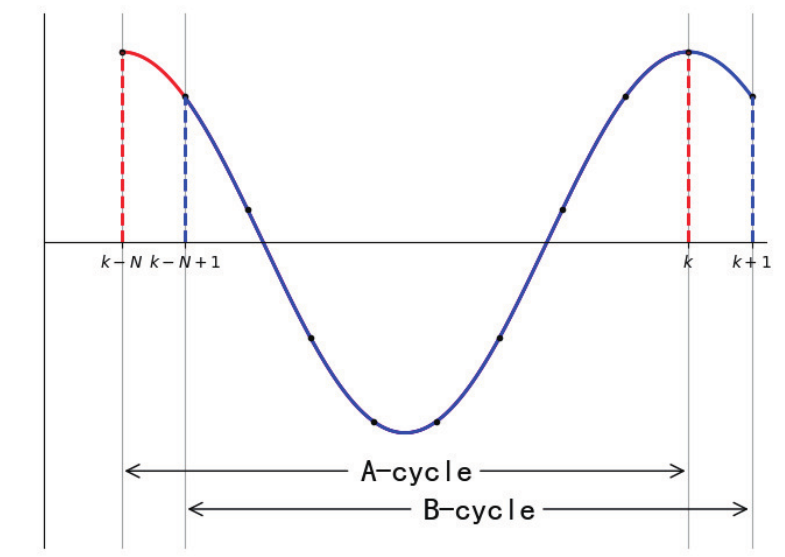
Figure 2. Cycles selecting